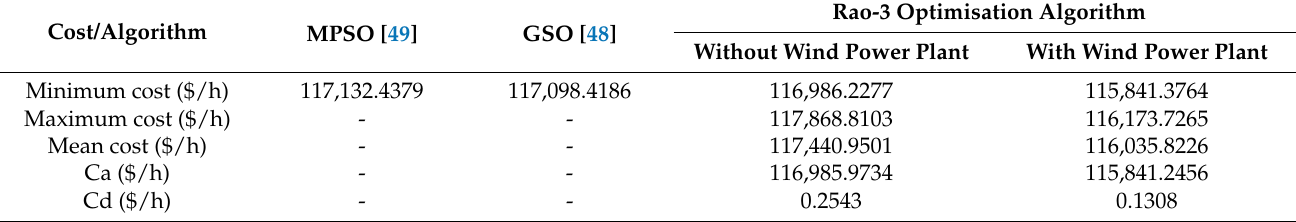
Table 4. Statistical analysis considering VPL and